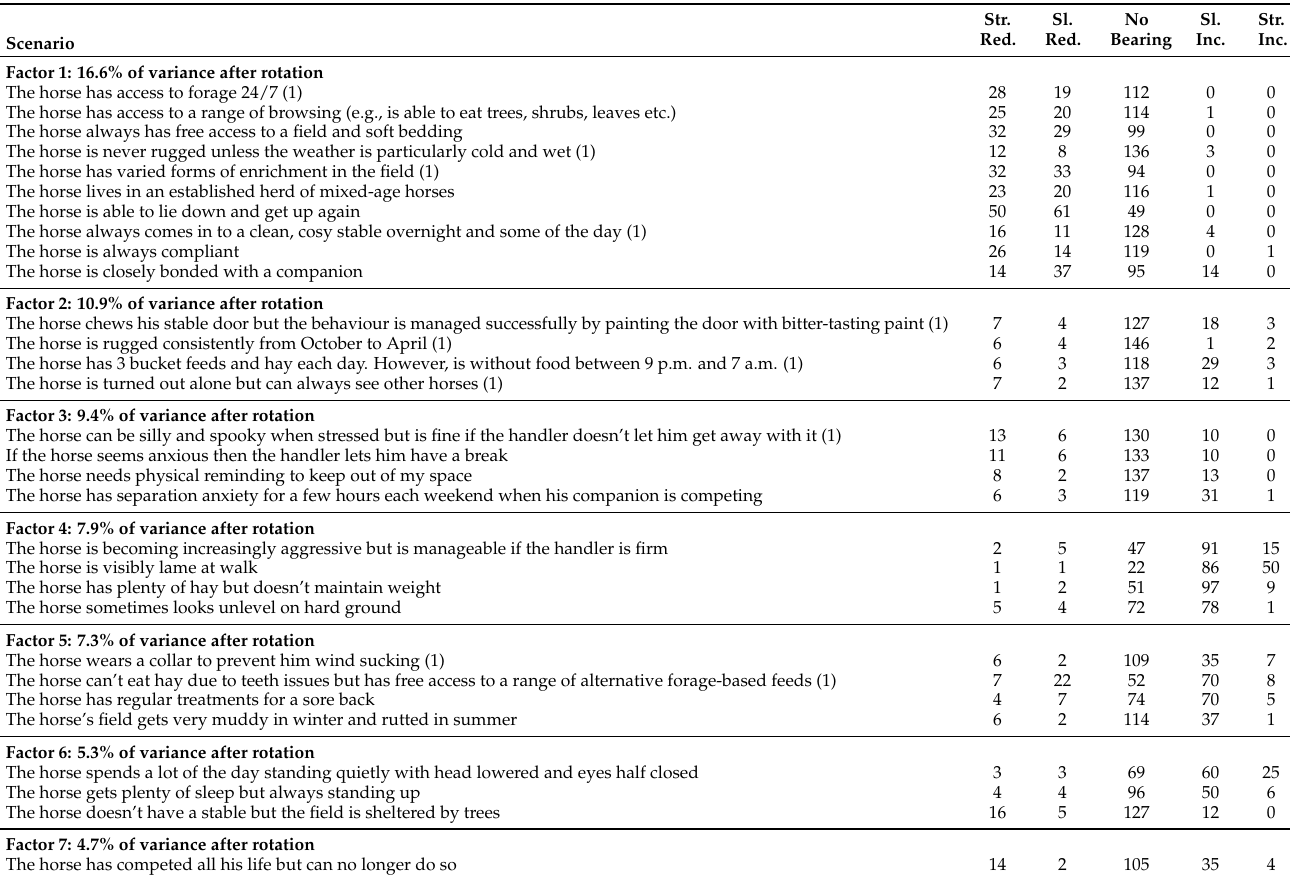
Str. Sl. No Sl. Str. Red. Red. Bearing Inc.